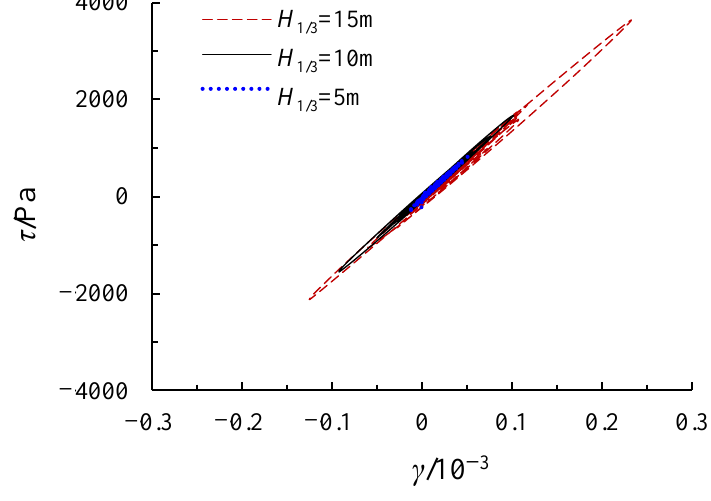
Figure 19. Soil stress–strain curves around the GBF for different wave loads.